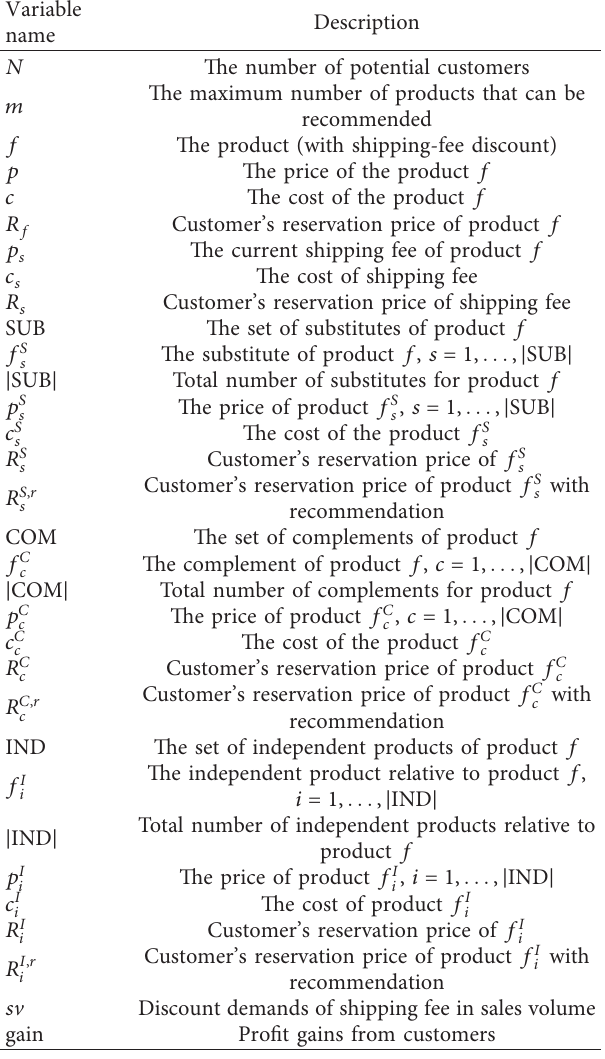
Figure 2: Process of the proposed model. Table 1: Model